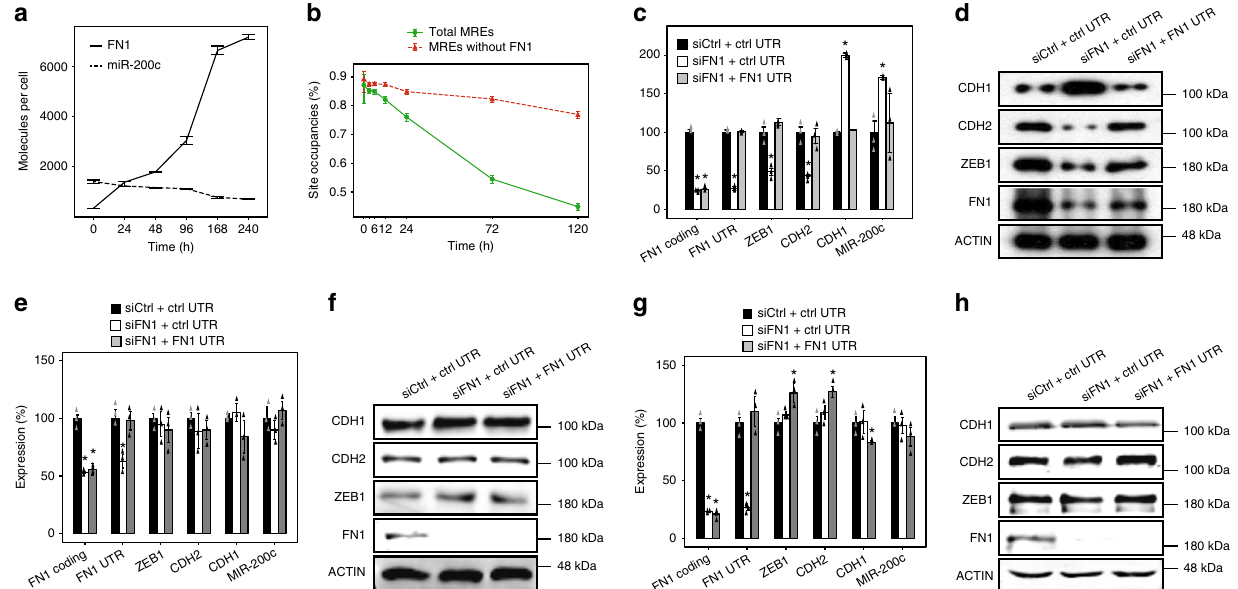
Fig. 4 FN1 is a functional ceRNA for miR-200c to regulate EMT. a Absolute quanti fi cation of the numbers of FN1 mRNA and miR-200c transcripts during TGF- β -induced EMT in MCF10A cells. b Graph showing the dynamics of modeled 8-mer miR-200c binding site occupancy during TGF- β -induced EMT in MCF10A cells using pictar-based predictions. c Graph showing the level of indicated RNAs in MCF10A cells during TGF- β -induced EMT subjected to indicated treatments. d Same as ( c ) for immunoblotting analysis. e Graph showing the level of indicated RNAs in MCF10A cells during TGF- β -induced EMT subjected to indicated treatments, using cells whose DICER1 has been knocked down. f Same as ( e ) for immunoblotting analysis. g Graph showing the level of indicated RNAs in MCF10A cells during TGF- β -induced EMT subjected to indicated treatments, using cells whose conserved miR-200c binding site in FN1 3 ′ UTR has been mutated with CRISPR-Cas9. h Same as ( g ) for immunoblotting analysis. n = 3; error bars indicate the means ± s.d. * p <